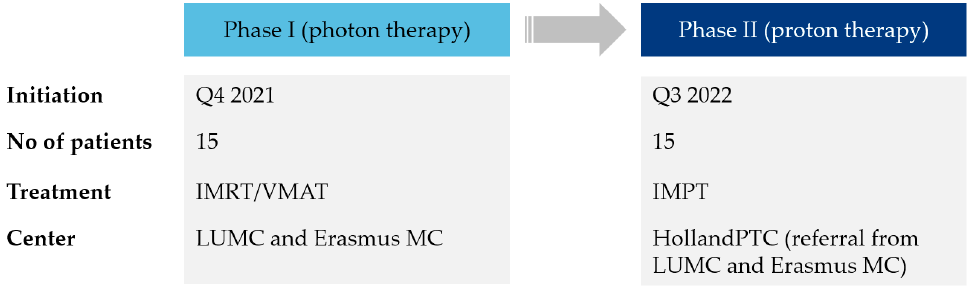
Figure 2. Schematic scheme of PROTECT’s study design. IMRT, intensity-modulated radiation therapy; VMAT, volumetric-modulated arc therapy; IMPT, intensity modulated proton therapy.